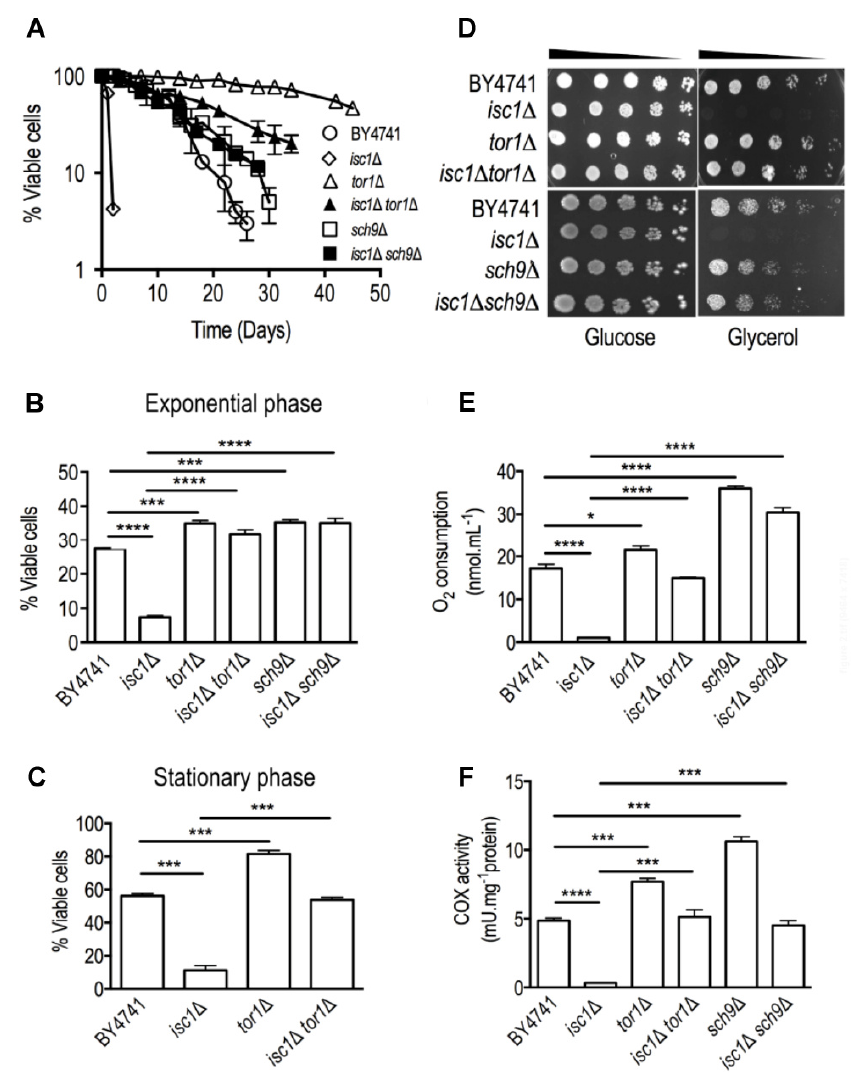
FIGURE 2: The deletion of TOR1 and SCH9 abolishes the shortened CLS, oxidative stress sensitivity and mitochondrial dysfunctions dis- played by isc1 Δ cells. (A) S. cerevisiae BY4741 , isc1 Δ, tor 1Δ and isc 1Δ tor1 Δ, sch9 Δ and isc1 Δ sch9 Δ cells were grown in SC-medium and kept in the medium at 26°C. The viability was determined by standard dilution plate counts and expressed as the percentage of the colony- forming units at time T in relation to T 0 . Values are mean ± SD of at least three independent experiments. (B, C) Yeast cells were grown in SC- medium to the exponential phase (B) or stationary phase (48 hours after exponential phase) (C) and exposed to 1.5 mM H 2 O 2 for 60 min (B) or 300 mM H 2 O 2 for 30 min (C). Cell viability was determined by standard dilution plate counts and expressed as the percentage of the colo- ny-forming units (treated cells versus untreated cells). Values are mean ± SD of at least three independent experiments. ****p<0.0001. ***p<0.001. (D) S. cerevisiae BY4741, isc1 Δ, tor1 Δ and isc1 Δ tor1 Δ, sch9 Δ and isc1 Δ sch9 Δ cells were grown in SC-medium to the exponential phase and then diluted to OD 600 =0.1. Fivefold dilution series were spotted on YPD (glucose) or YPG (glycerol) medium and cells were grown at 26°C for 4 days. (E) Oxygen consumption rate was measured in cells grown to PDS phase, as described in Materials and Methods . Values are mean ± SD of at least three independent experiments. ****p<0.0001; *p<0.05. (F) Cytochrome c oxidase (COX) activity was determined in cells grown to the PDS phase. Cells were lysed and enzymatic activity was measured as described in Materials and Methods . Values are mean ± SD of at least three independent experiments. ****p<0.0001;